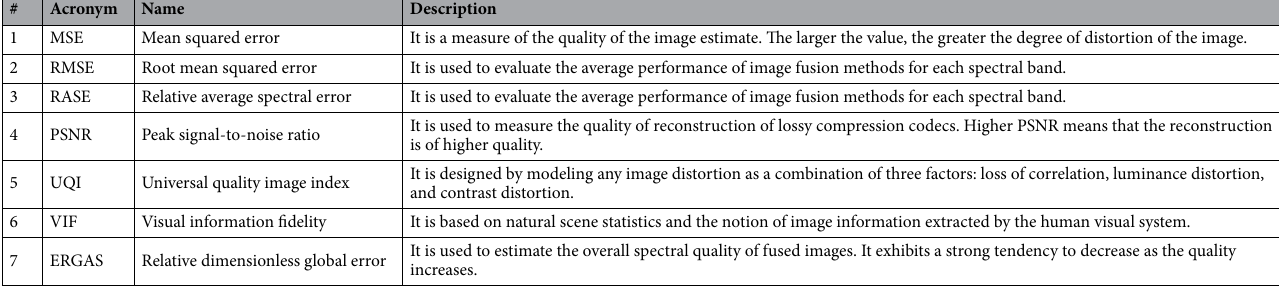
Table 2. Image quality assessment (IQA) metrics for evaluating